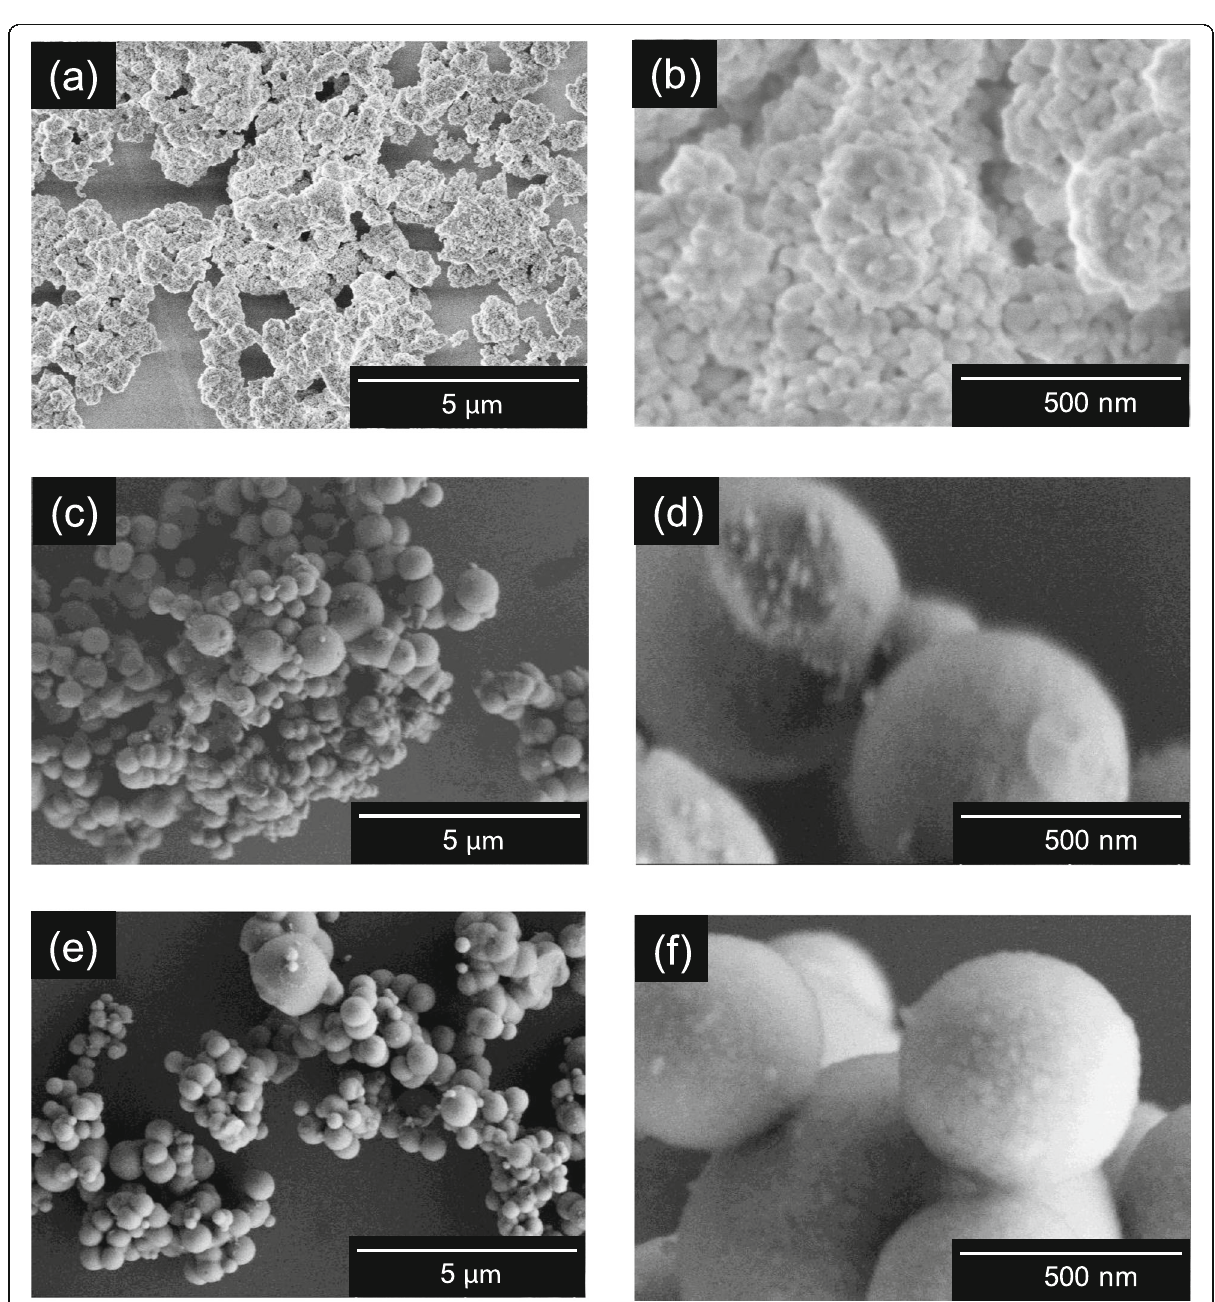
Fig. 2 SEM images of a low magnification and b high magnification of commercially available ZrO 2 , c low magnification and d high magnification of ZrO 2 MARIMO, and e low magnification and f high magnification of sintered ZrO 2